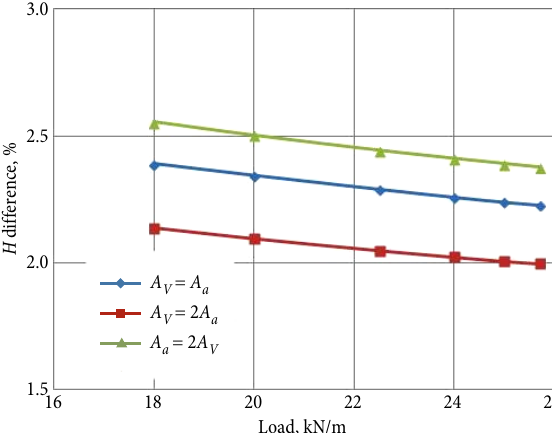
Fig. 8. The difference of the thrust force of the stress-ribbon structure and stress-ribbon structure with external tendons (in